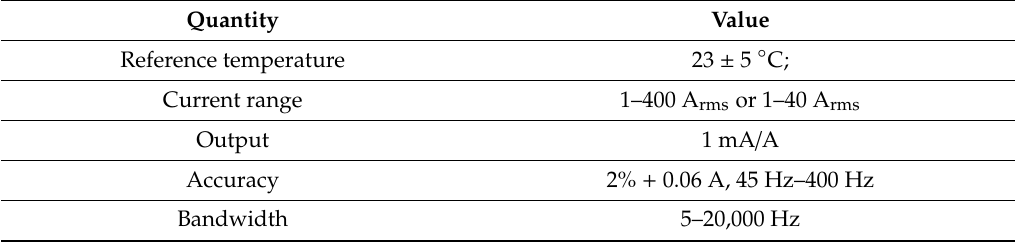
Table 4. Technical data for the fluke i400current probe.